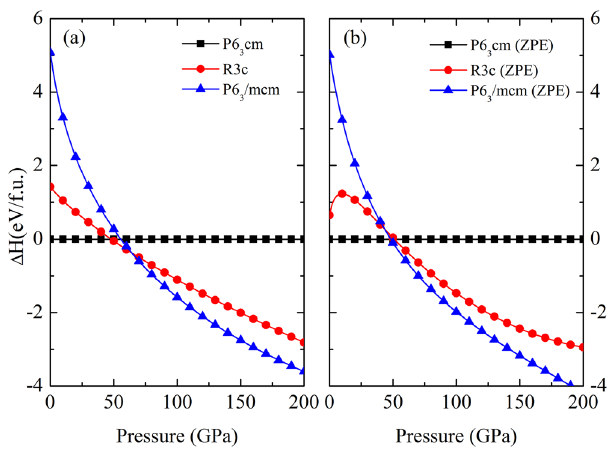
Figure 2. (a) The relative enthalpy as a function of pressure of Li 5 MoH 11 without ZPE and (b) the relative enthalpy as a function of pressure of Li 5 MoH 11 with ZPE.